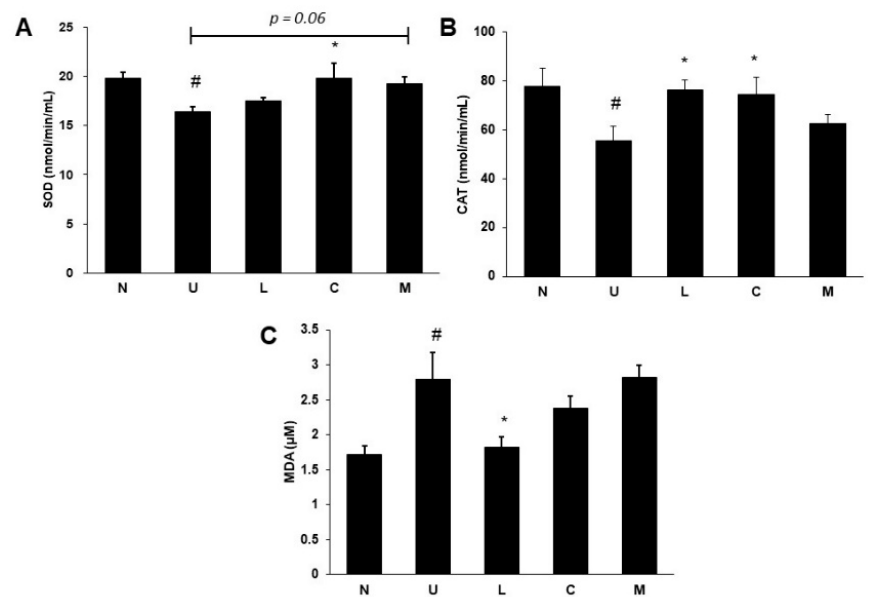
Figure 4. Effects of Lycium barbarum polysaccharides (LBP) and capsaicin (CAP) on ( A ) Superoxide dismutase (SOD) activity, ( B ) Catalase (CAT) activity, and ( C ) Malondialdehydes (MDA) levels in serum. N: control group, U: ulcerative colitis induced group, L: LBP treated group, C: CAP treated group, M: mixed LBP and CAP treated group. Data are presented as mean ± SEM and analyzed by one-way ANOVA and Fisher’s least significant difference test ( n = 8). # p < 0.05 compared to the N group. * p < 0.05 compared to the U group.